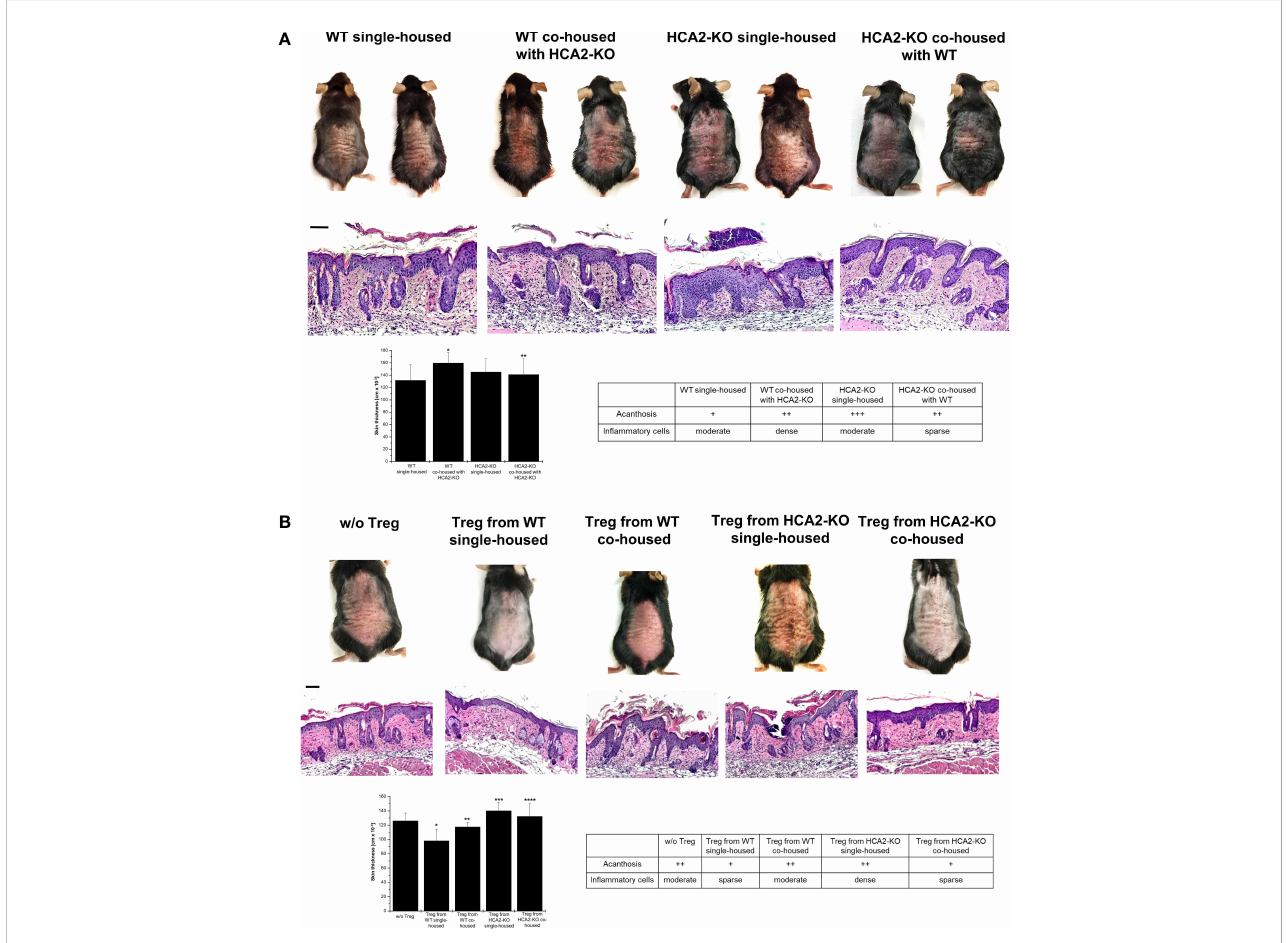
FIGURE 7 The skin microbiota determines the suppressive activity and function of Treg in HCA2-KO mice. (A) WT mice were co-housed with HCA2-KO mice for 1 month (each group contained 6 animals). Mice were treated topically with 5% IMQ cream on the shaved backs for 7 days. Biopsies were taken, paraf fi n embedded sections stained with H&E and analyzed histopathologically. Single housed HCA2-KO and WT mice served as controls. Scale bar = 100 µm. The skin thickness was measured using a spring-loaded micrometer. Student t test and one-way ANOVA was performed. *P < 0.015 WT single-housed vs WT co-housed, **P < 0.04 HCA2-KO single-housed vs HCA2-KO co-housed; P ANOVA = 0.00758. The acanthosis and space of in fl ammatory cells was scored. Data are presented from one of three independent experiments. (B) WT mice were co-housed with HCA2-KO mice for 1 month. Treg were obtained either from 6 co-housed HCA2-KO or 6 co-housed WT mice and injected i.v. into IMQ-treated WT mice. As controls, Treg from 6 single-housed HCA2-KO or 6 single-housed WT mice were injected in the same fashion. Biopsies were taken, paraf fi n embedded sections stained with H&E and analyzed histopathologically. Scale bar = 100 µm. Skin thickness was measured using a spring-loaded micrometer. Student t test and one-way ANOVA were performed. *P < 0.009 w/o Treg vs Treg from WT single-housed, **P < 0.015 Treg from WT single-housed vs Treg from WT co-housed, ***P < 0.0025